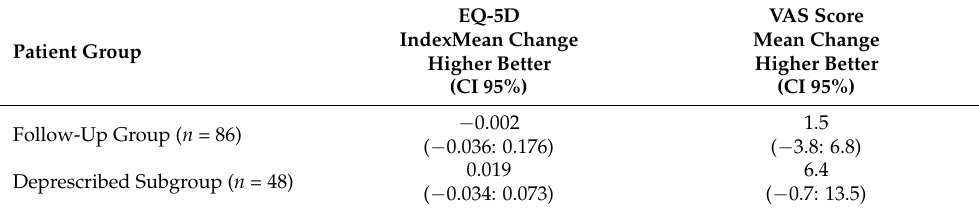
Table 2. The mean difference in quality of life (QoL), the EQ-5D index, and VAS score, respectively, from baseline (before the medication review (MR)) to follow-up (3 months after the MR). The mean difference is shown for patients in the Follow-Up Group ( n = 86), who completed the QoL questionnaire at baseline and follow-up, and for the Deprescribing Subgroup ( n = 48), respectively. For the EQ-5D index and VAS score, a higher score indicates a better